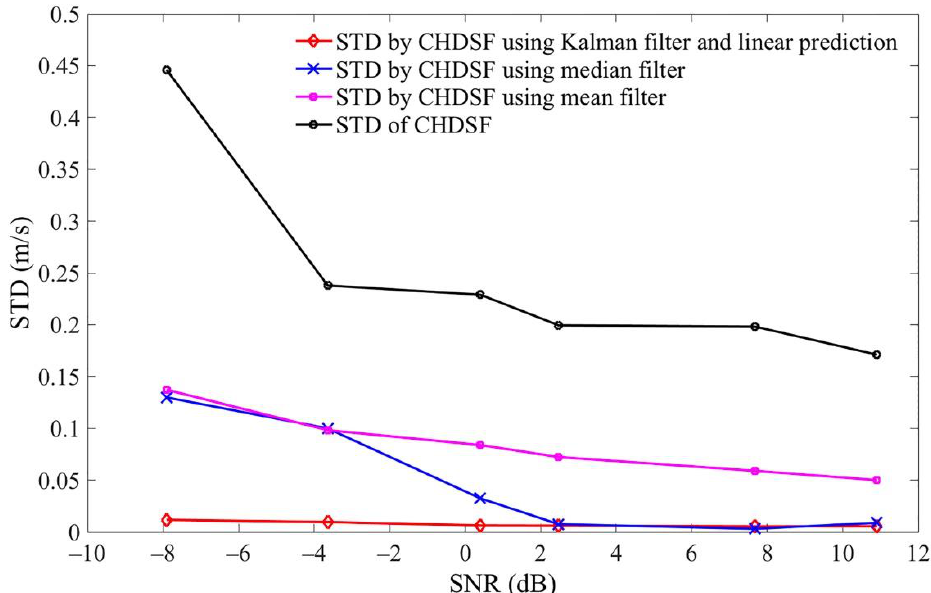
Figure 9. Standard deviation of velocity measured by CHDSF and CHDSF using 3 filters. Table 4. Standard deviation of measured velocity by CHDSF and CHDSF using 3 filters.